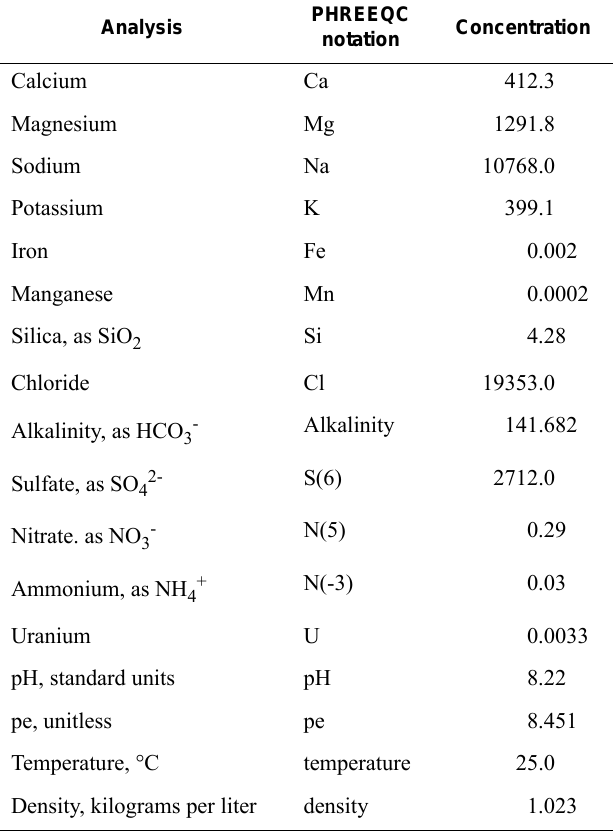
Table 9. Seawater